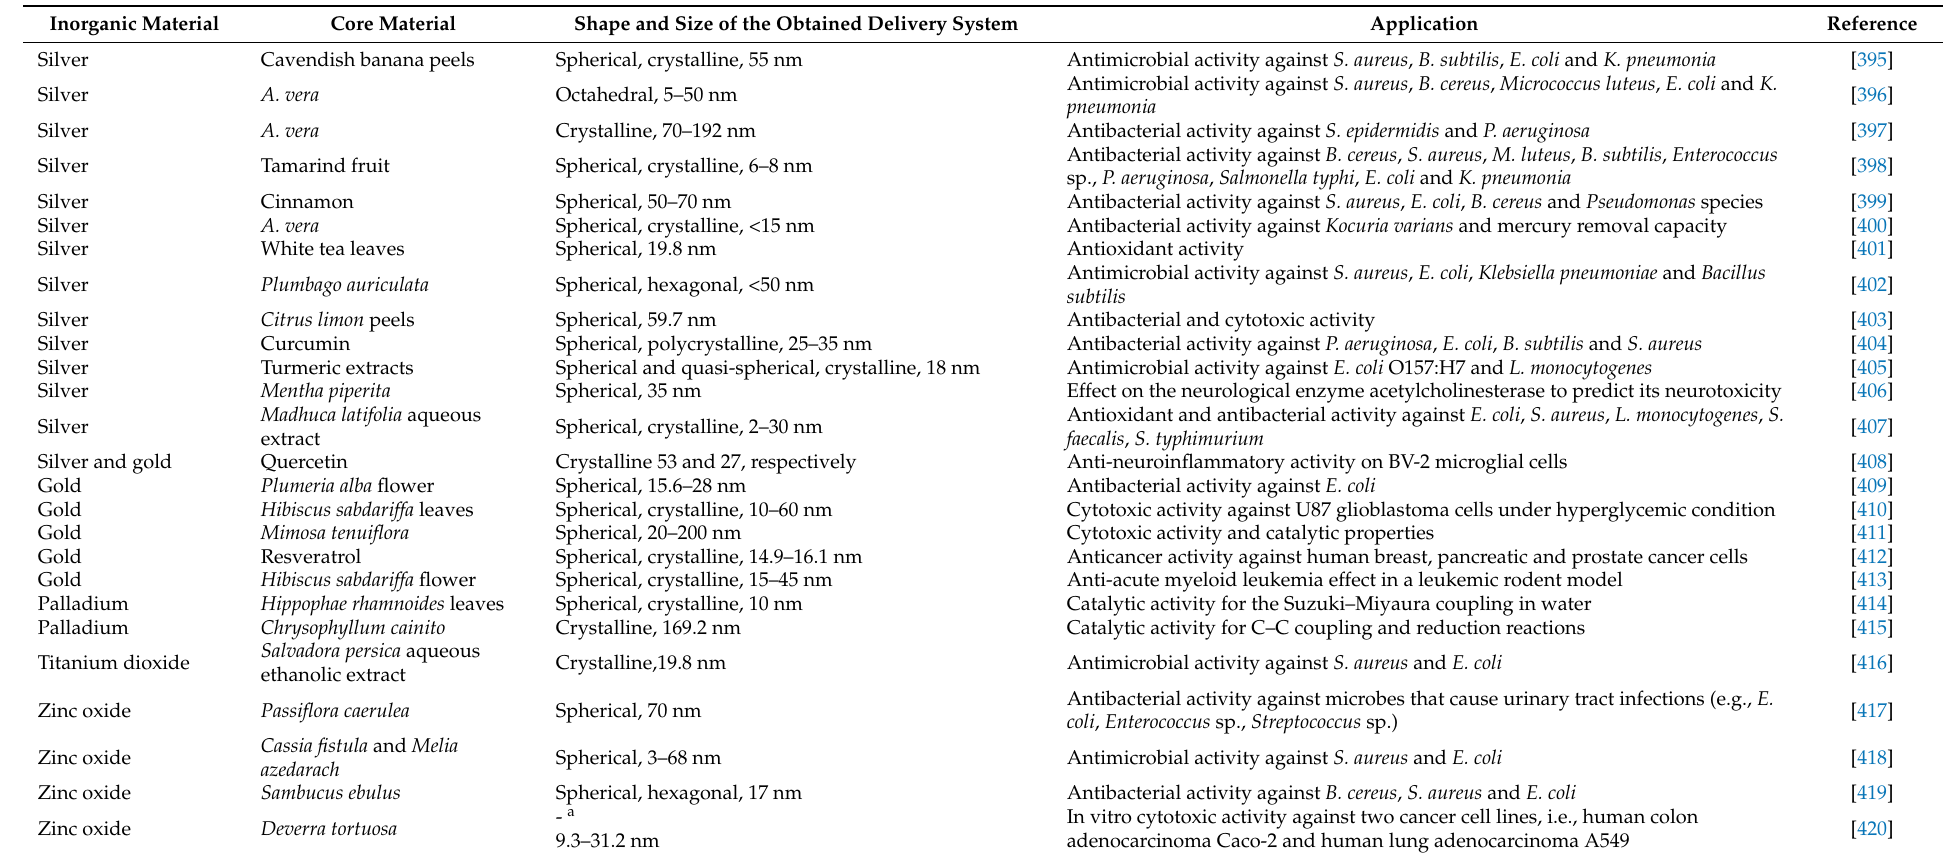
Table 5. Overview of different inorganic nanoparticles as carriers for pure plant bioactive compounds, extracts and essential